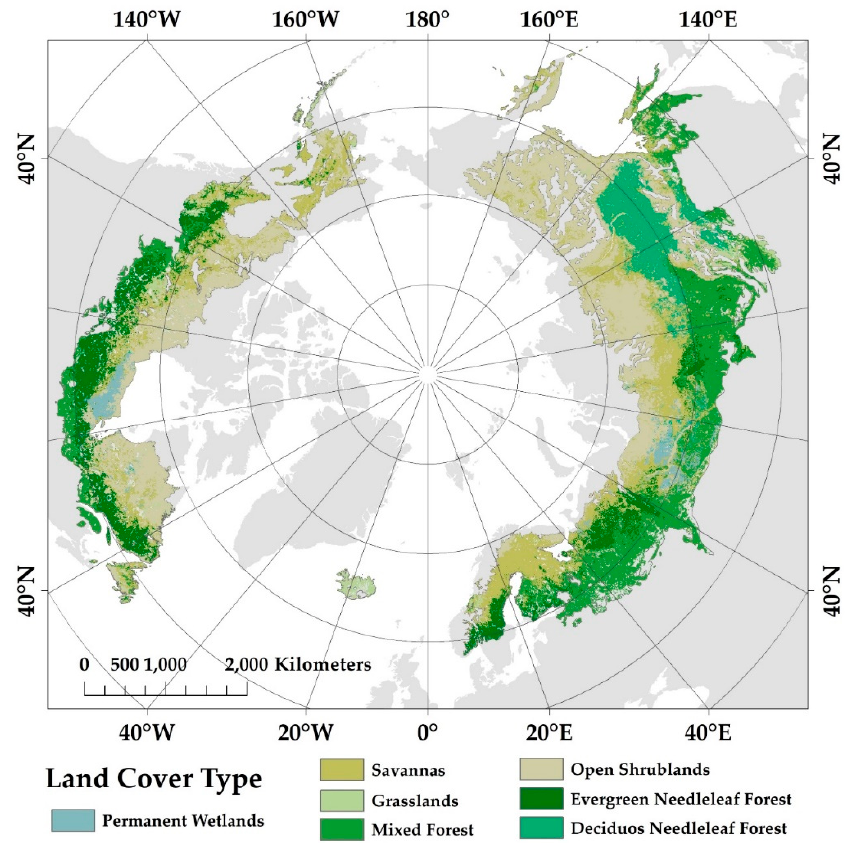
Figure 1. Land cover types for the boreal region based on the International Geosphere-Biosphere Programme (IGBP) classification, derived from MCD12C1 land cover type product.